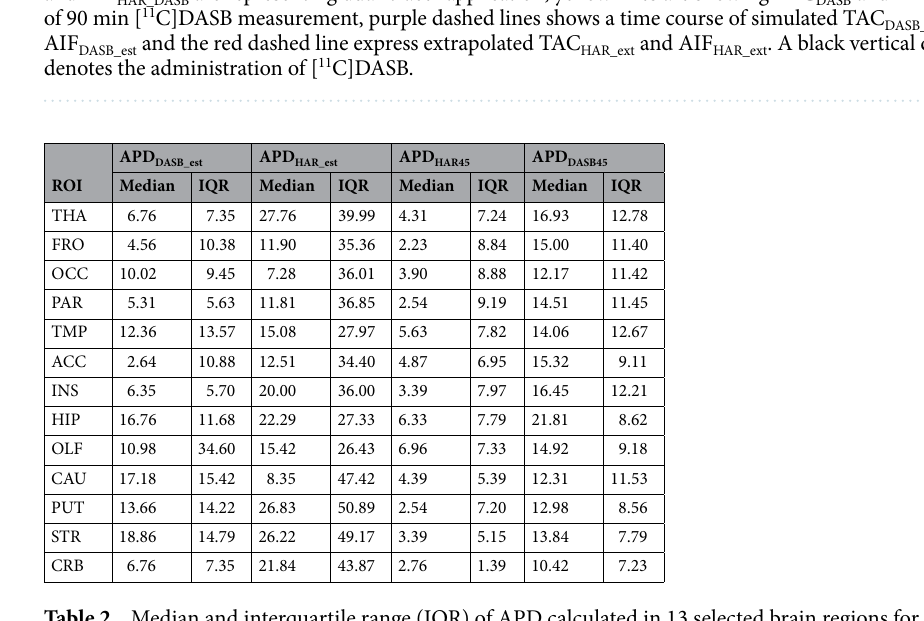
Table 2. Median and interquartile range (IQR) of APD calculated in 13 selected brain regions for the comparison of